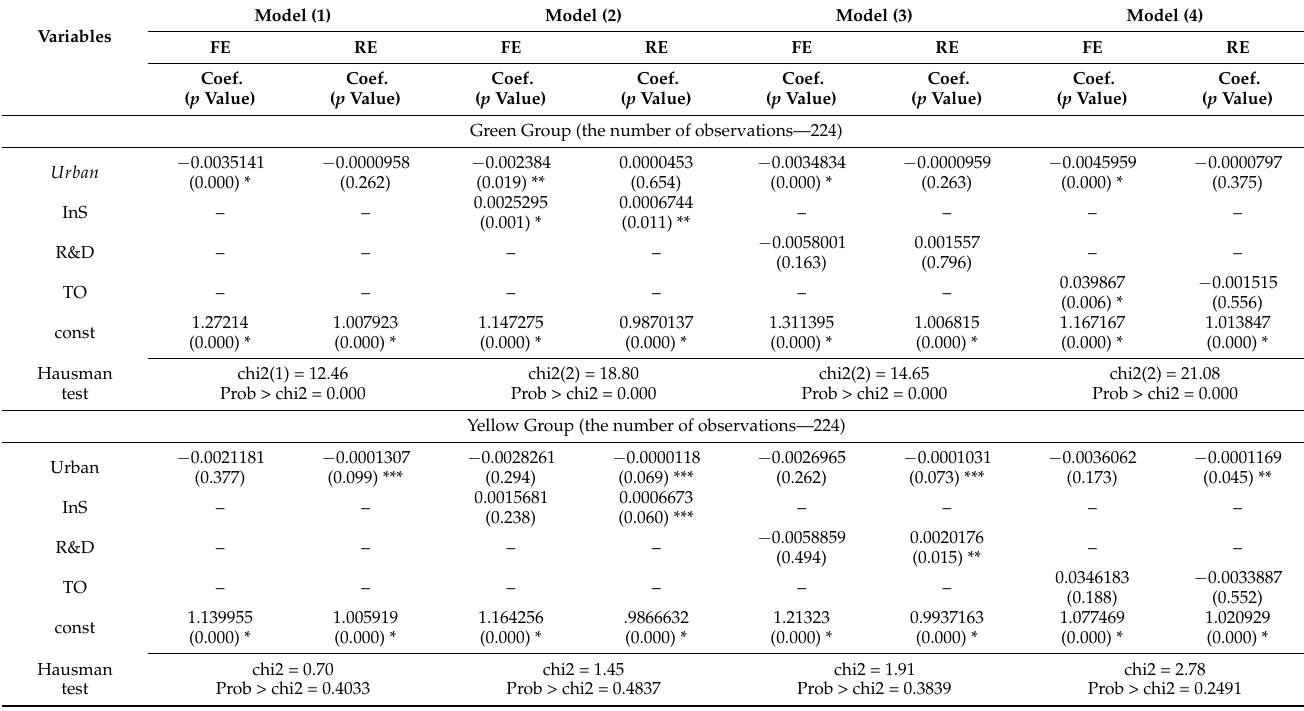
Table 5. The findings of the static model for analysing urbanisation impact on green economic growth in the green and yellow group countries (applied the fixed and random effects